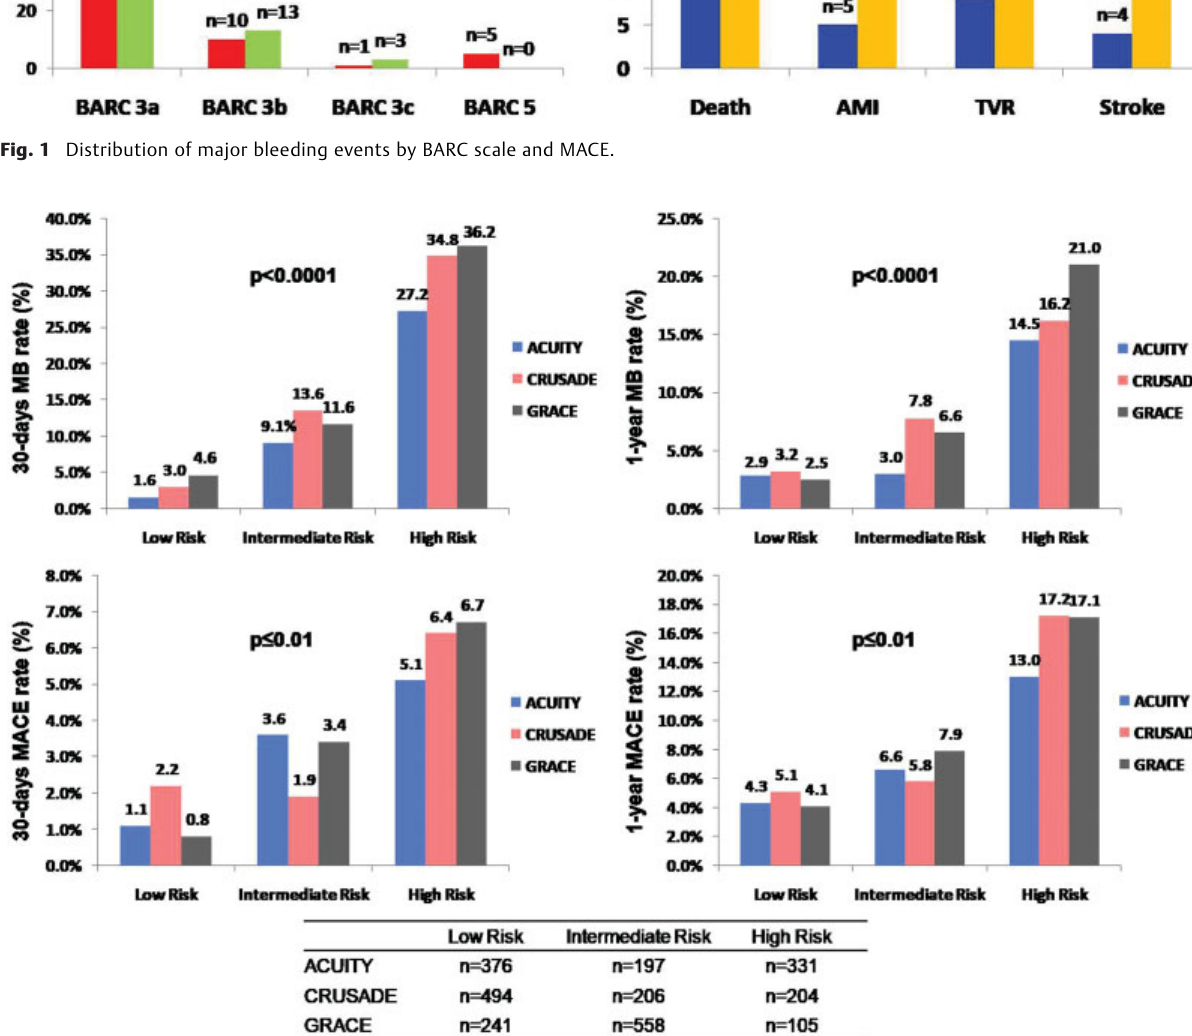
Fig. 2 Incidence of major bleeding events and MACE across ACUITY, CRUSADE, and GRACE risk score